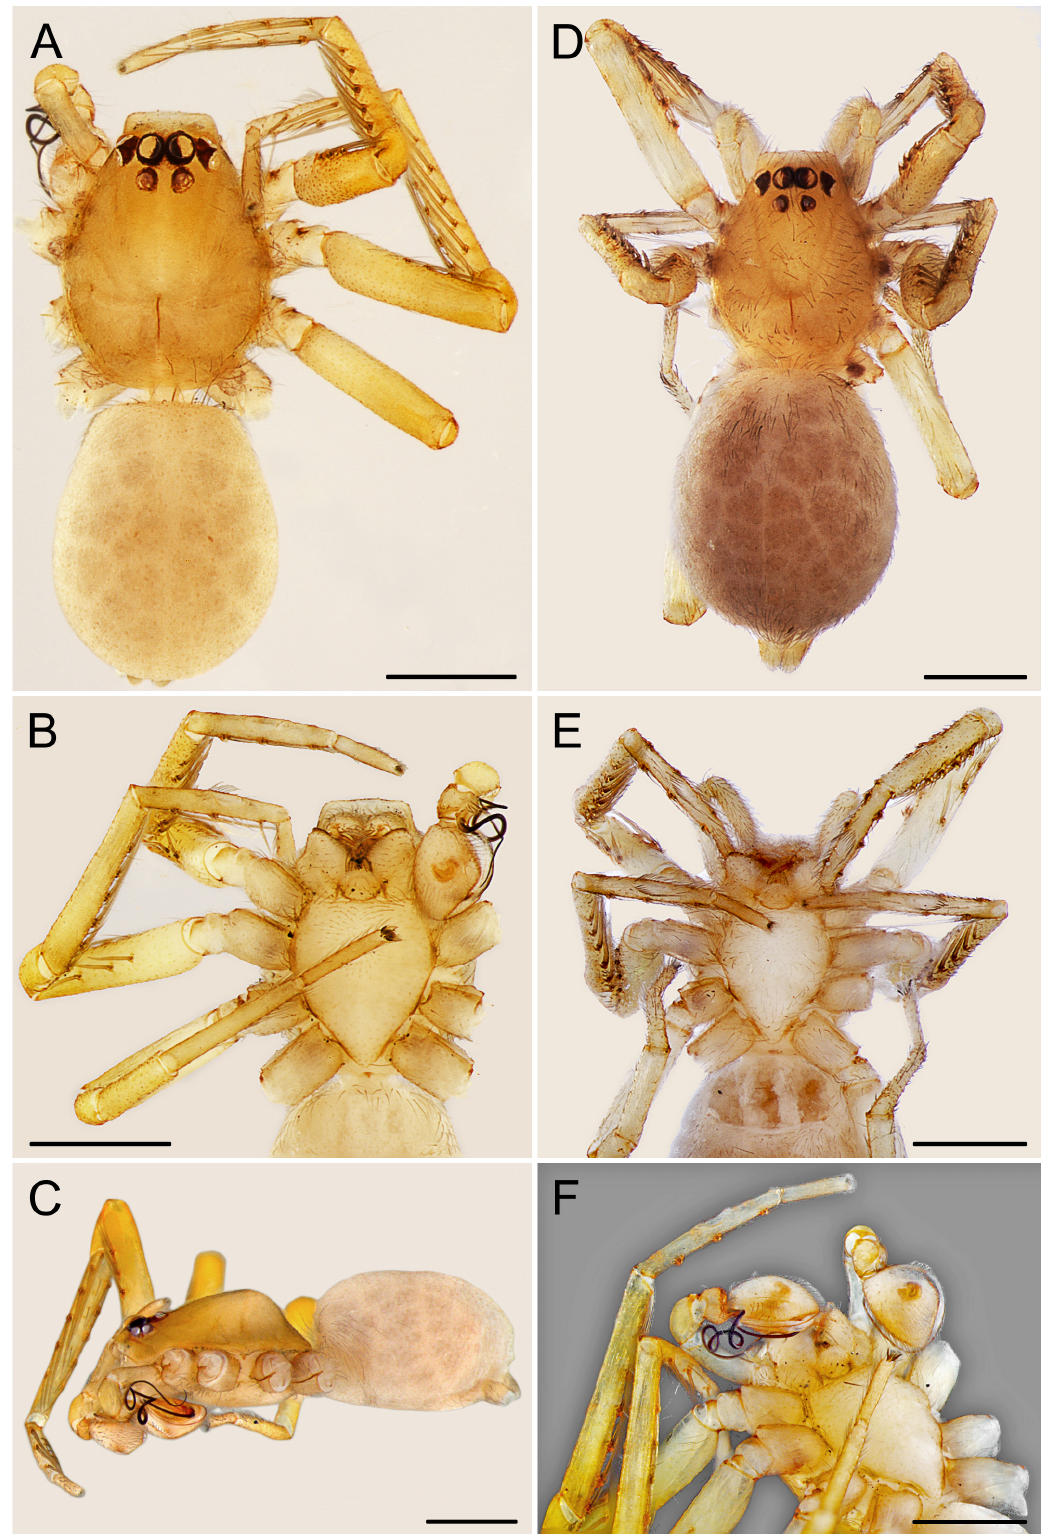
Fig. 1. Hortipes gigapophysalis sp. nov. A . Male habitus, dorsal view. B . Male prosoma, ventral view. C. Male habitus, lateral view. D . Female habitus, dorsal view. E . Female prosoma, ventral view (epigyne removed). F . Male prosoma, ventrolateral